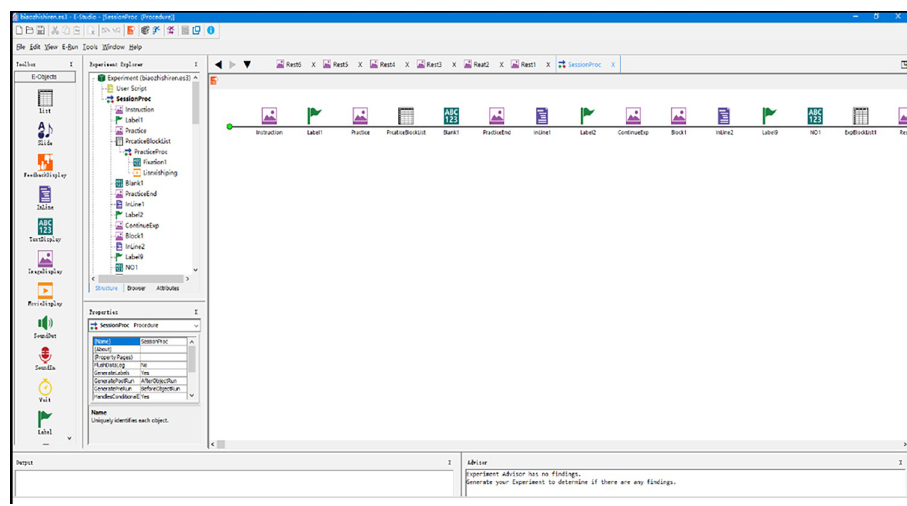
Fig 7. E-Prime simulation software interface and experimental